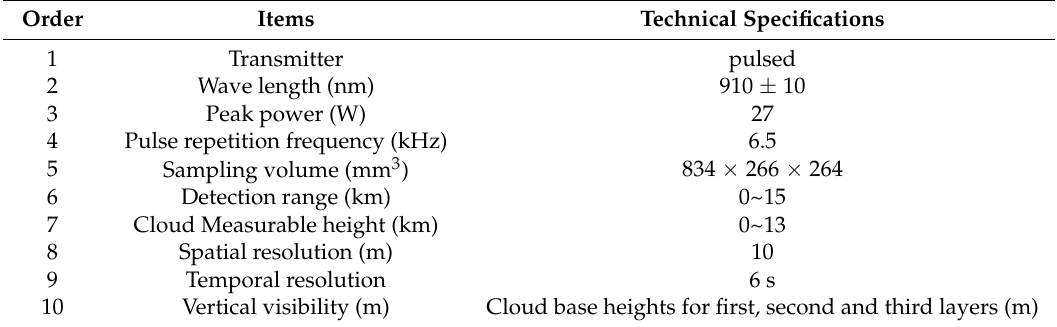
Table 4. Major technical parameters and data for CL51 ceilometer.